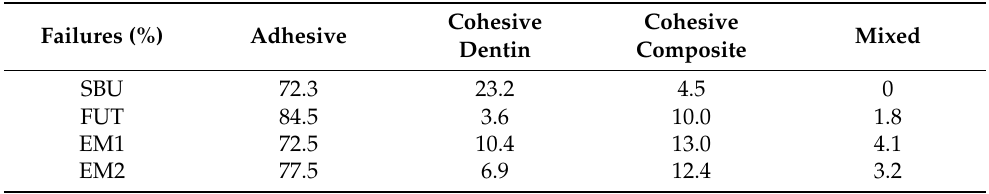
Table 6. Summary of the fractographic analysis showing the different types of failures seen in each experimental group (presented as